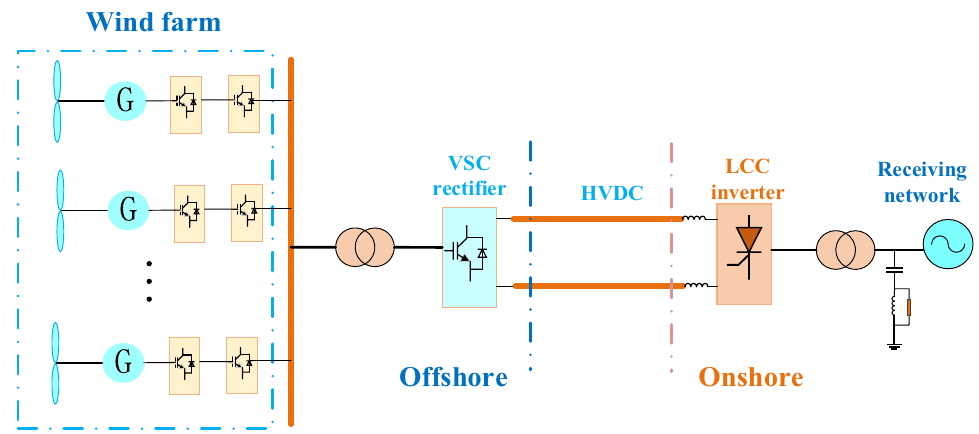
Fig. 11 Hybrid HVDC transmission system